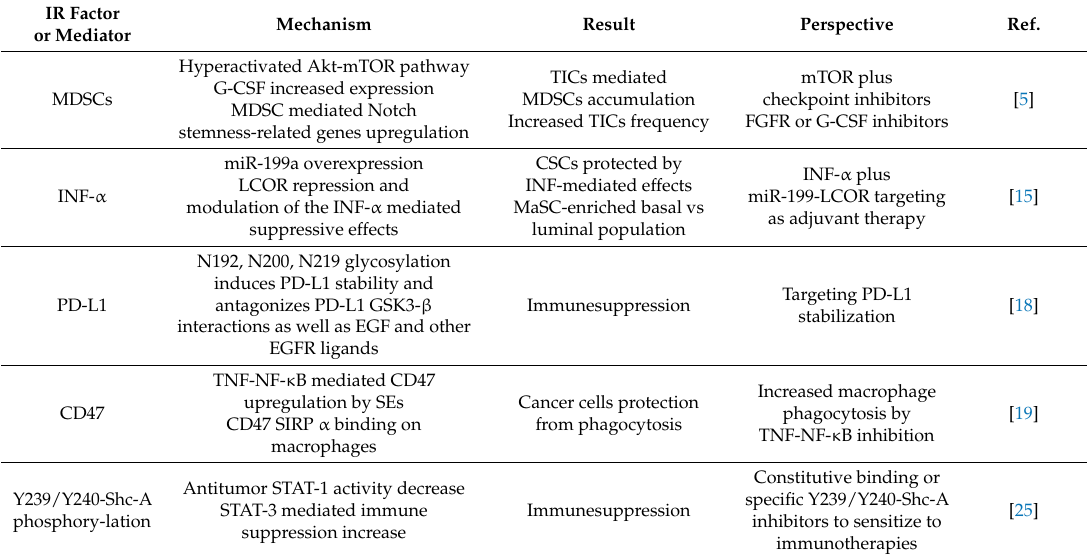
Table 1. Immune Response (IR) Mechanisms and Tumor Initiating Cells (TICs), Cancer Stem Cells (CSCs) or Immune